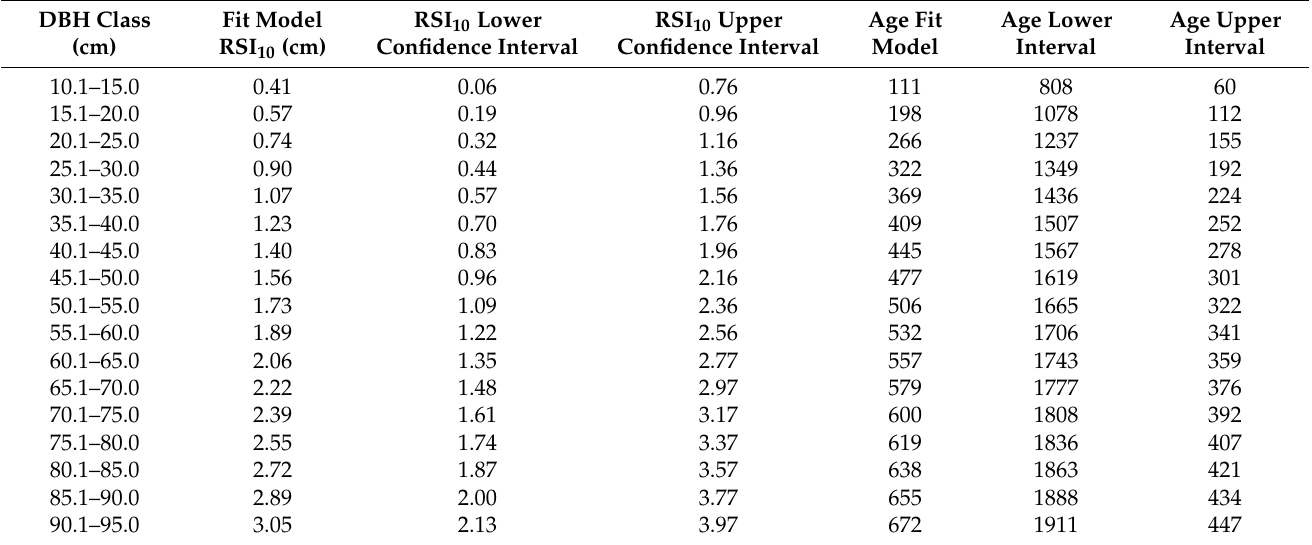
Table 2. The models of RSI 10 and the ages of the trees with their simulated 95% confidence